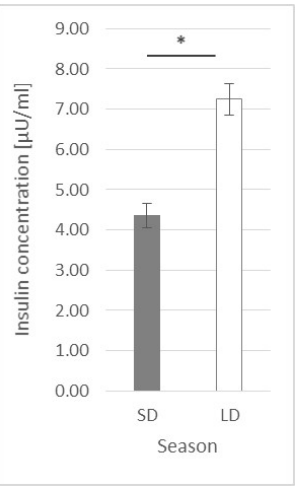
Figure 7. Plasma insulin concentration—comparison between short-day (SD) and long-day (LD) seasons at a 0 h time point; *—indicates p ≤ 0.05, according to Student’s t -test ( n = 24).